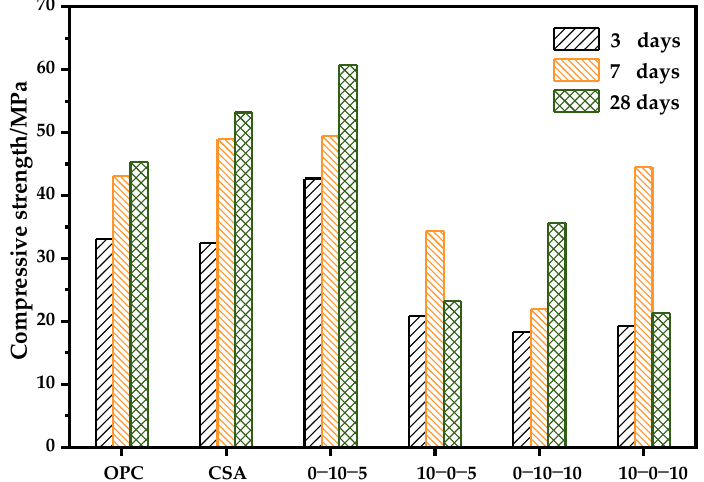
Figure 13. Effect of CS on the compressive strength of the single cement systems.